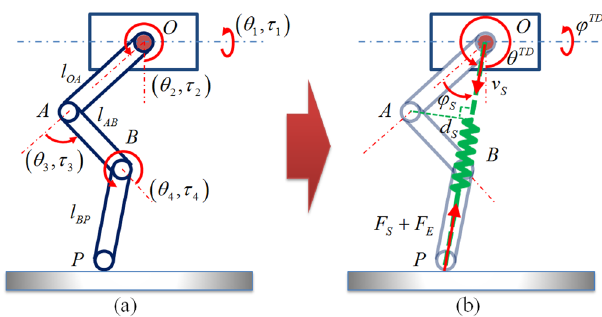
Figure 8. Extended schematic diagram of the one-legged